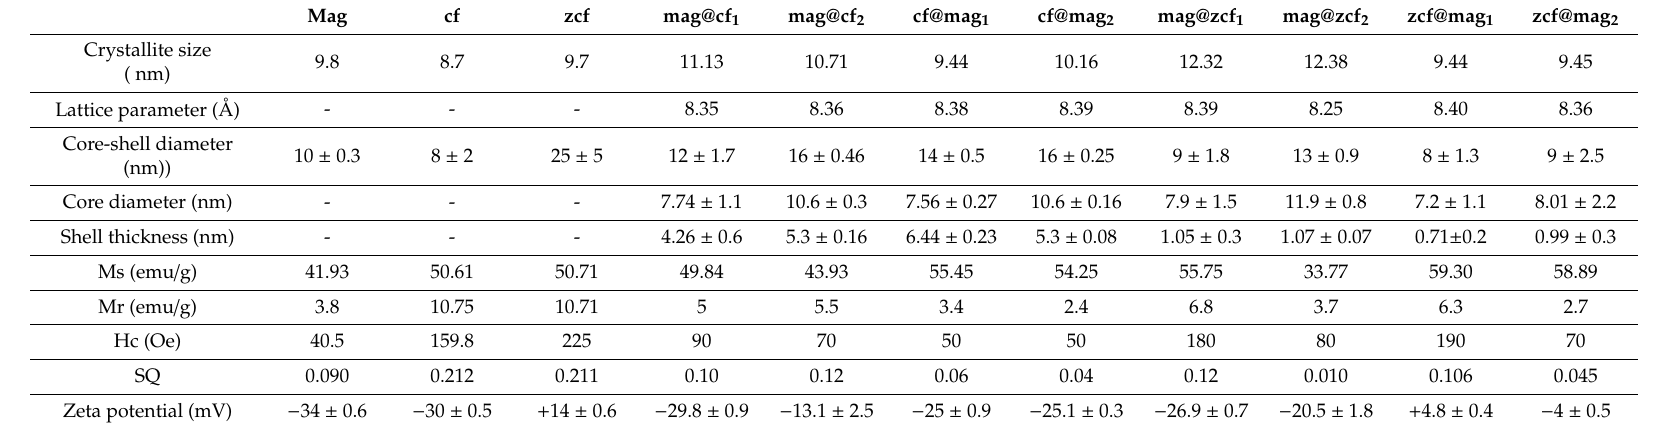
Table 2. Crystalline properties, zeta potential, size and magnetic properties of the various core nanoparticles and core-shell